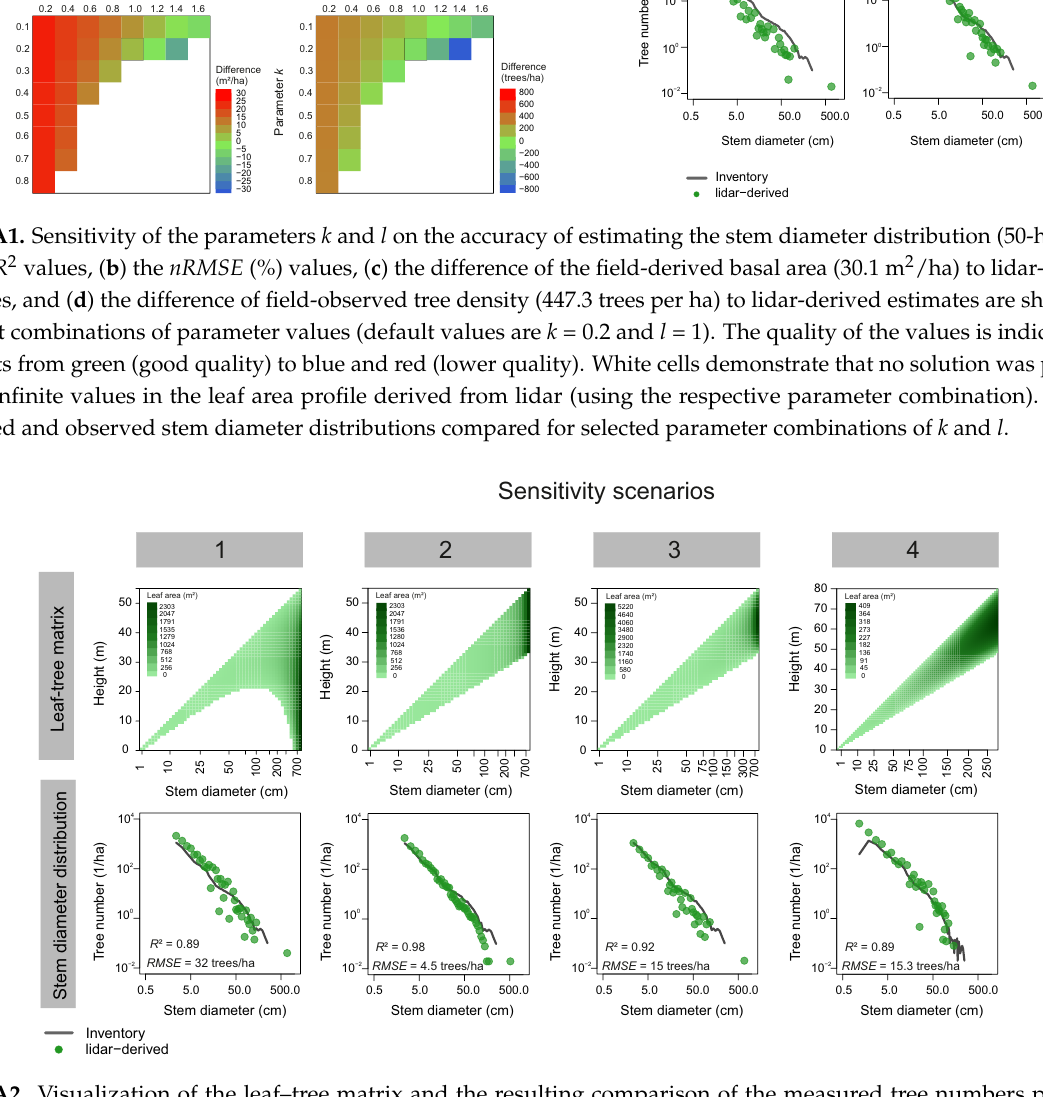
Figure A2. Visualization of the leaf–tree matrix and the resulting comparison of the measured tree numbers per stem diameter class (from inventory) with the estimated tree numbers (from lidar) for different sensitivity analysis. Upper graphics: each column in the matrix reflects the leaf area contribution of one tree to different height layers. Different columns represent different stem diameter classes. The leaf area values are shown using a color gradient from light green (low leaf area) to dark green (high leaf area) (white represents no leaf area). Lower graphics: green points show the estimated tree numbers from lidar for each stem diameter class and the grey line shows the observed stem numbers in the inventory. Values of R 2 and RMSE are given (see Table 3 for further results and a description of changed model assumptions in each